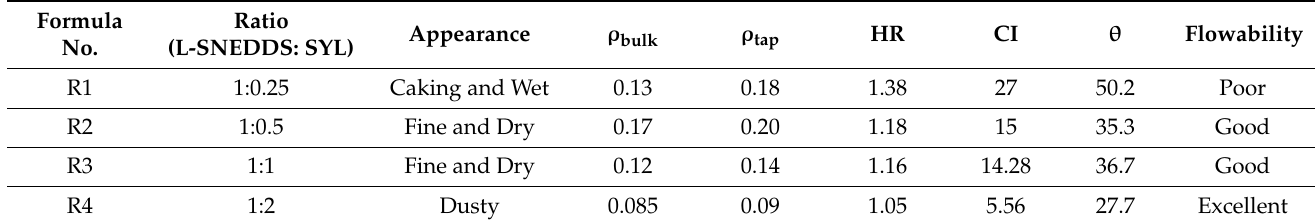
Table 6. Effect of L-SNEDDS: Syloid (SYL) ratio on the flowability of S-SNEDDS powder.